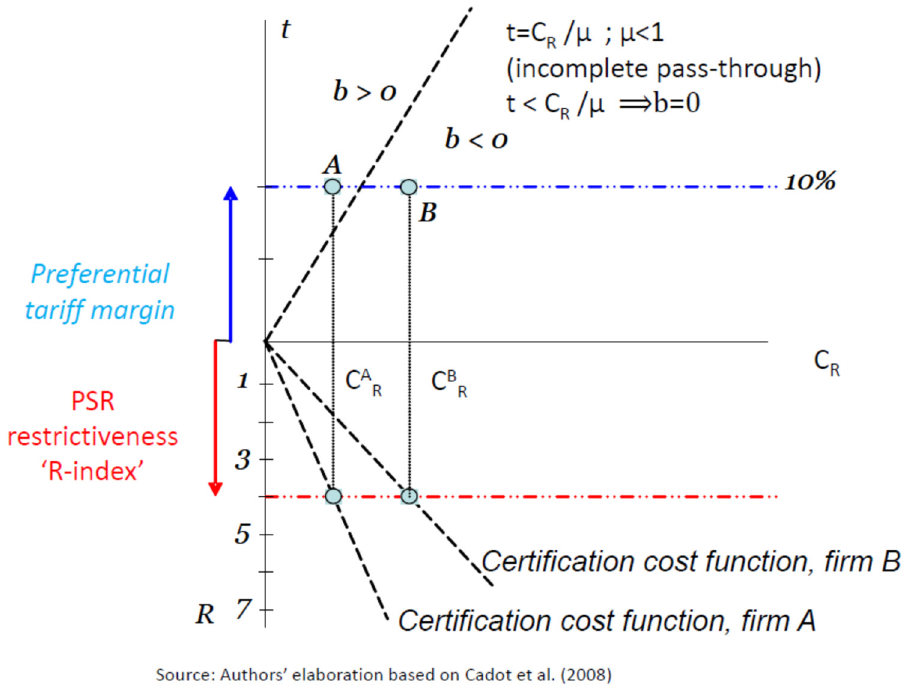
Figure 4. Variable certification costs, and utilization of preferences.